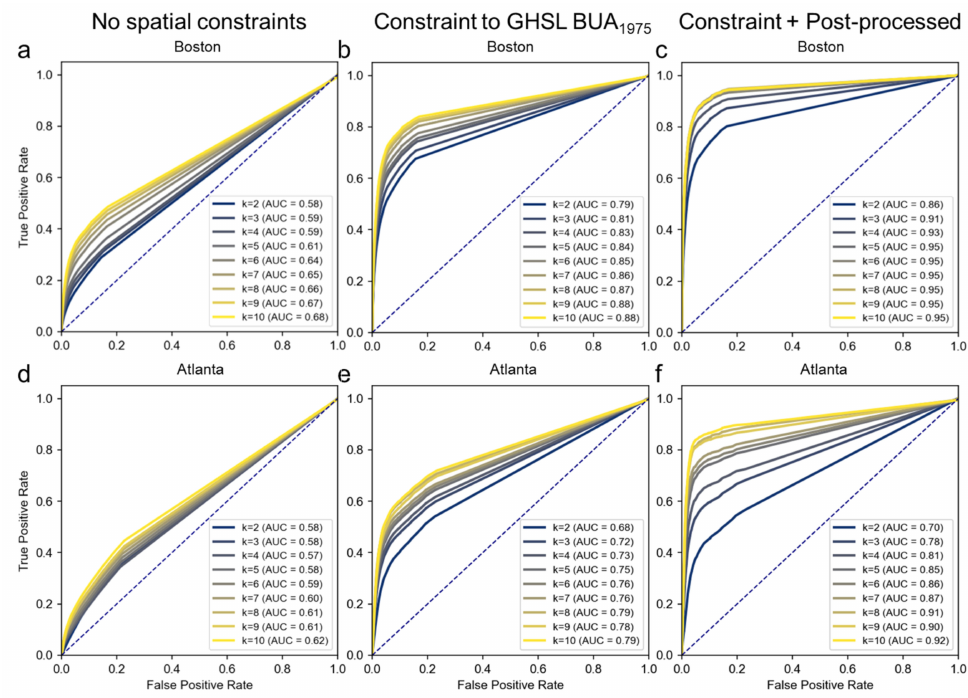
Figure 7. Evaluation of the map-extracted historical urban areas in the US study areas against HISDAC-US built-up property densities. ( a ) Receiver-Operator-Characteristic (ROC) plots for each clustering scenario (k from 2 to 10) without spatial constraints using GHSL 1975 built-up areas, ( b ) after applying the spatial constraints, and ( c ) after post-processing the extracted areas by removing small segments (<50 px) in Boston. Panels ( d – f ) show the ROC plots for the same scenarios in the Atlanta study area,